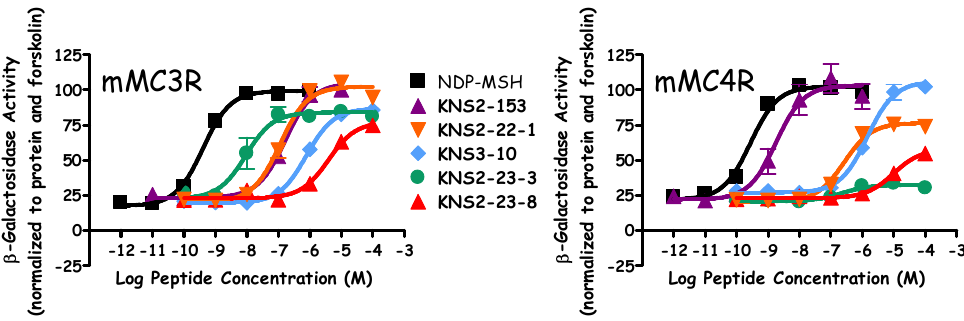
Figure 2. Illustration of the agonist pharmacology of NDP-MSH, KNS2-153 , KNS2-22-1 , KNS3-10 , KNS2-23-3 , and KNS2-23-8 at the mMC3R and mMC4R.